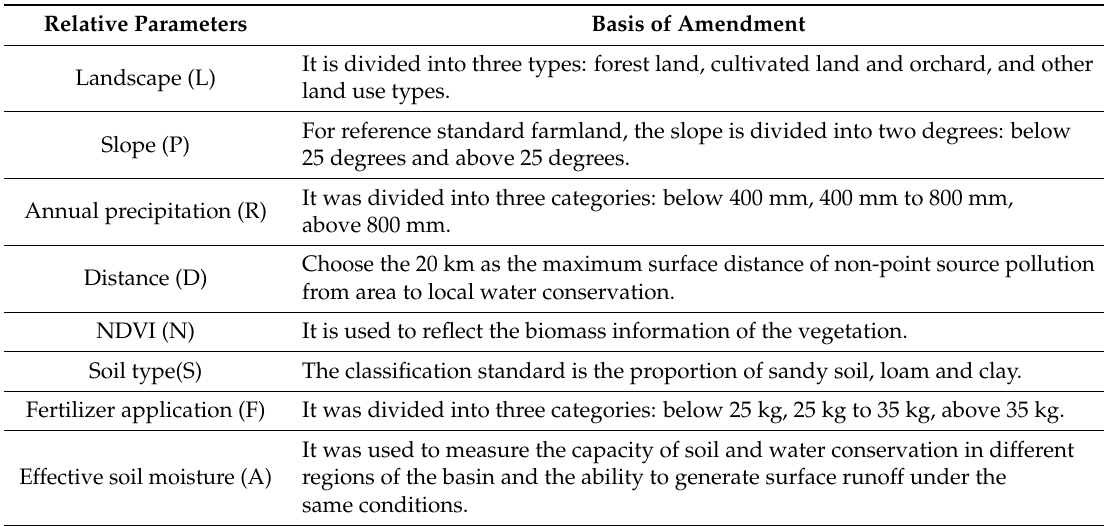
Table 5. The relative coefficient calculation methods